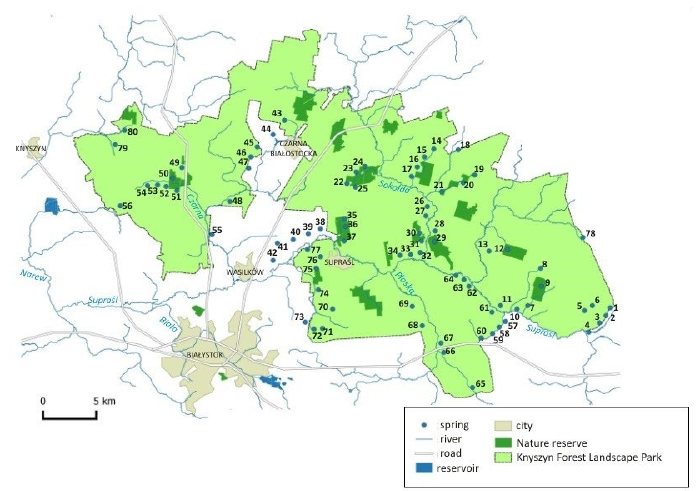
Figure 3. Locations of the studied springs in the Knyszyn Forest.